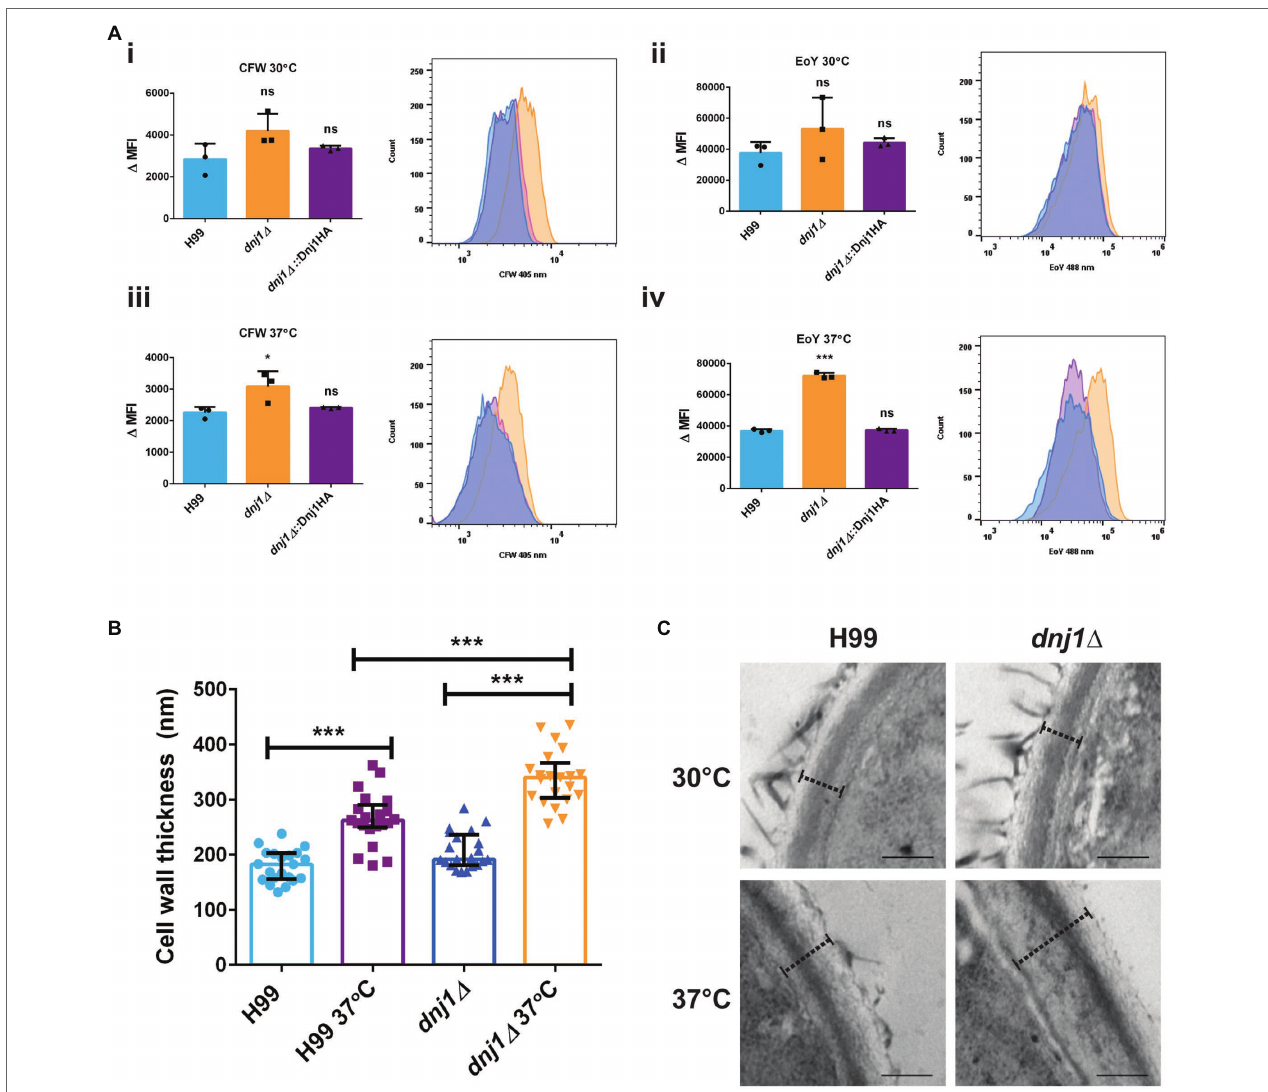
FIGURE 5 | The absence of DNJ1 alters the cell wall of C. neoformans . (A) The relative amounts of surface exposed cell wall components in the wild type (H99), dnj1 ∆ mutant, and complemented strains ( dnj1 ∆ ::Dnj1HA) were evaluated after growth at 30 or 37 ° C using CFW to stain chitin and eosin Y (EoY) to stain chitosan. The amount of staining was determined by quantifying mean fluorescence intensity (MFI) measured using flow cytometry. The results of three biological replicates are shown as individual dots, the bars represent the means, and error bars represent SD. Representative histograms of fluorescence intensity are also shown for each condition. (B) The cell wall thickness of the wild type and deletion mutant were measured from images obtained using transmission electron microscopy (TEM). For each condition, the cell walls of at least 20 cells were measured as indicated by dashed lines at four distinct points and averaged. The average cell wall thickness per cell is plotted as individual dots and the average and SD of measurements for each group are shown. (C) Representative images of the cell walls measured, scale bar = 200 nm. Statistical significance was determined using one way ANOVA’s with Tukey’s multiple comparisons (ns, non-significant; * p < 0.05 and *** p <